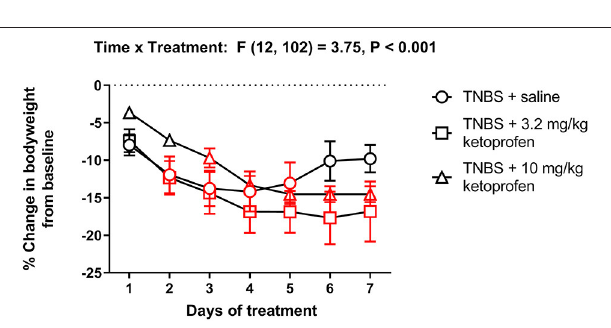
FIGURE 15 | Effect of repeated ketoprofen administration on the body weight of TNBS-treated mice. Percent change in body weight from baseline of TNBS-treated mice injected with saline, 3.2 or 10 mg/kg/day ketoprofen s.c. Compared to saline, ketoprofen did not significantly alter the body weight of TNBS-treated mice. Data are mean ± SEM and analyzed by two-way repeated measures ANOVA. TNBS + saline ( N = 8/day); TNBS + 3.2 mg/kg ketoprofen ( N = 7/day); TNBS + 10 mg/kg ketoprofen ( N = 5/day). Red points indicate significance ( P < 0.05) vs. day one by repeated measures two-way ANOVA with Dunnett’s